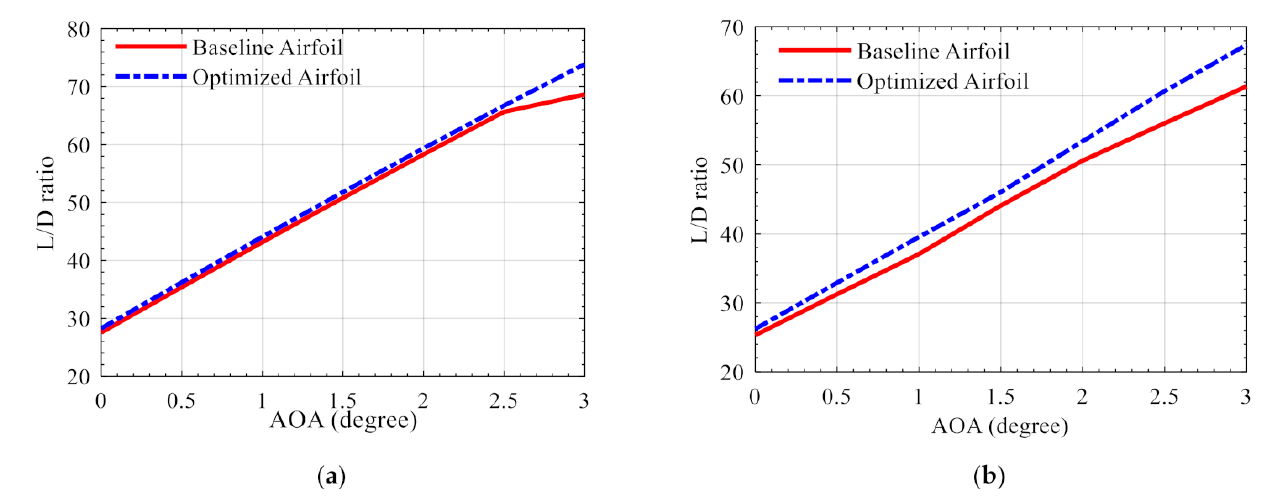
Figure 11. Comparison of coefficient of Lift to drag (L/D) ratio with respect to AOA ( a ) NREL-S821, ( b ) RAE-2822.